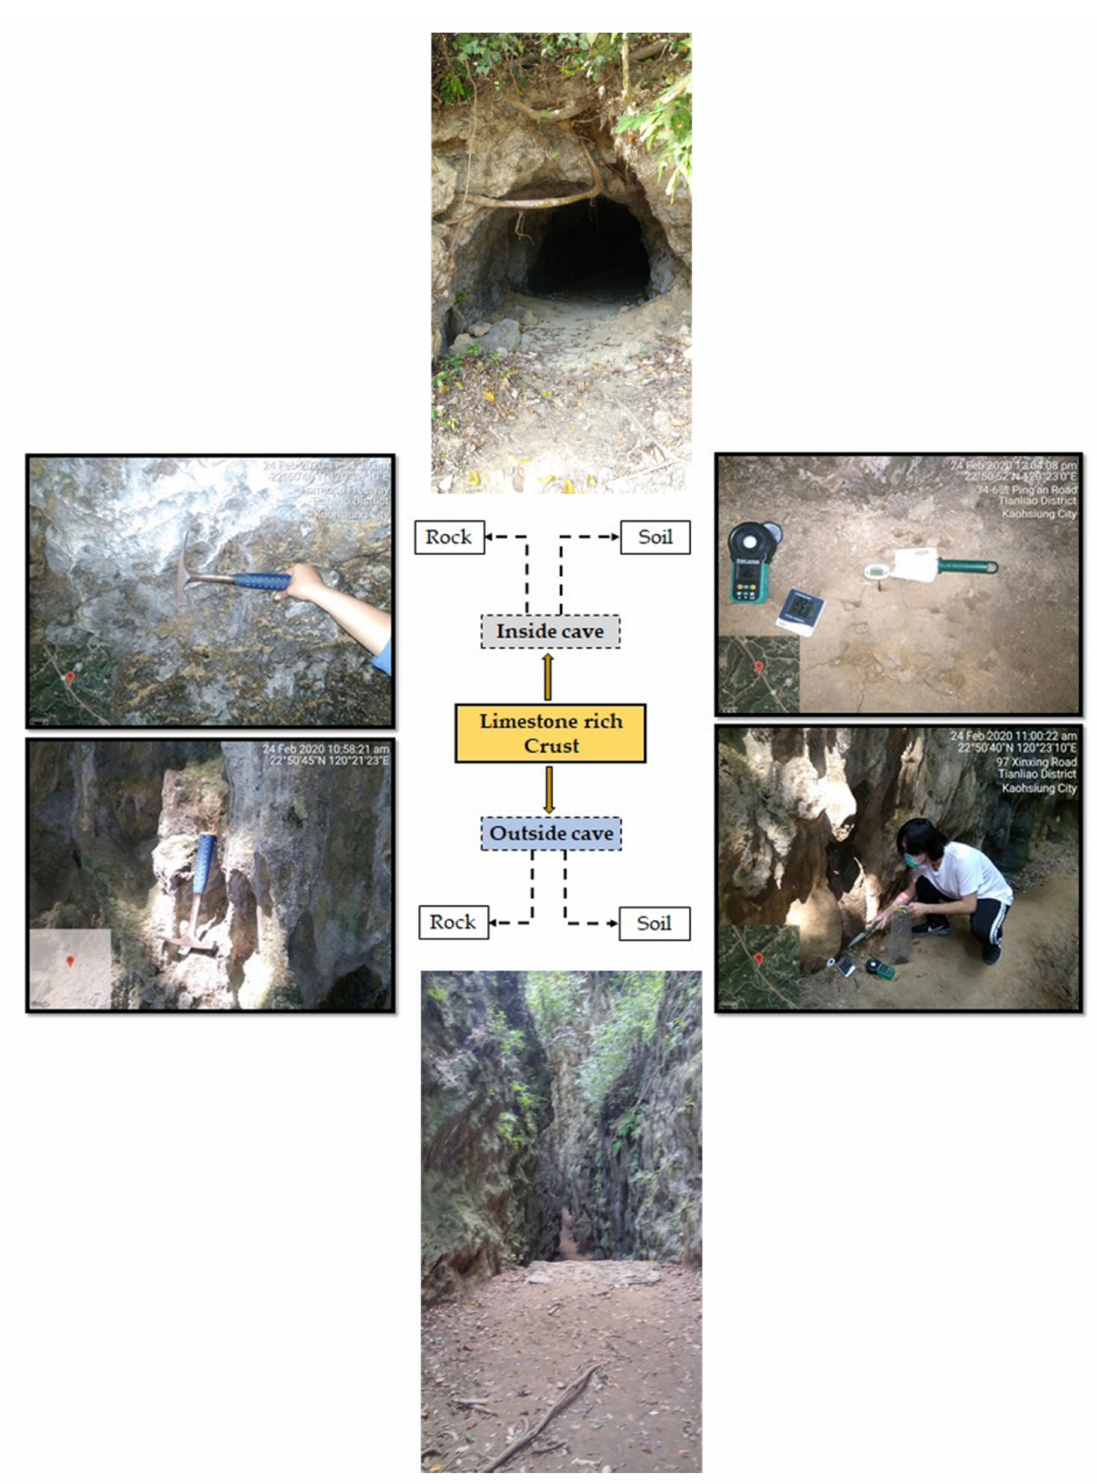
Figure 1. Sampling area and site